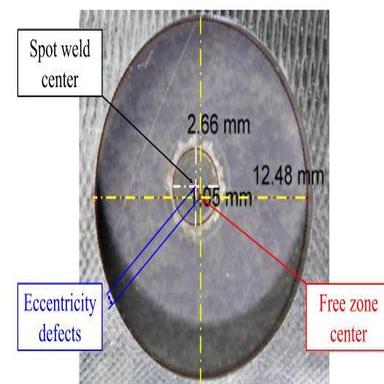
Illustration of an exteme eccentricity defect observed on a spot weld specimen.